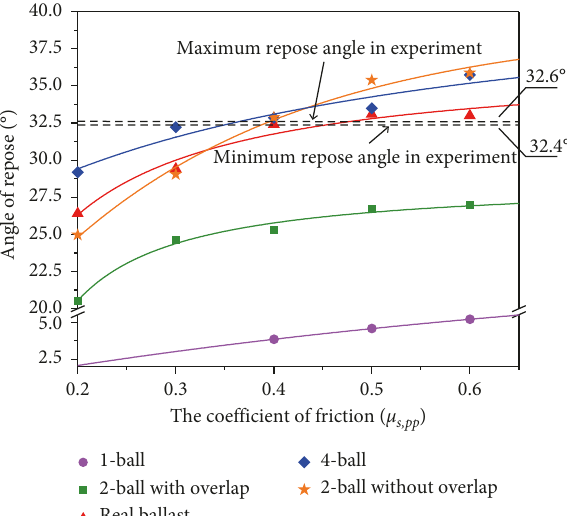
Figure 11: The effect of sliding coefficient of friction on the angle of